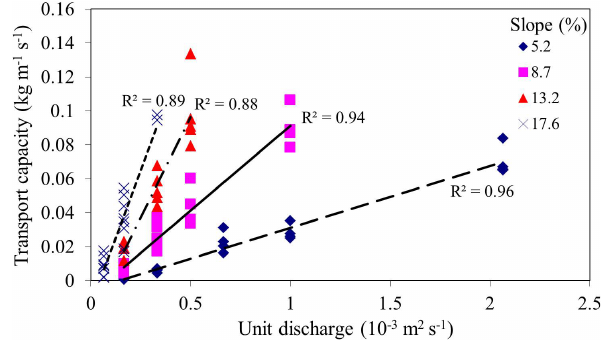
Fig. 3. Relationship between measured sediment transport capacity and unit discharge for different slope classes. All sediment types were